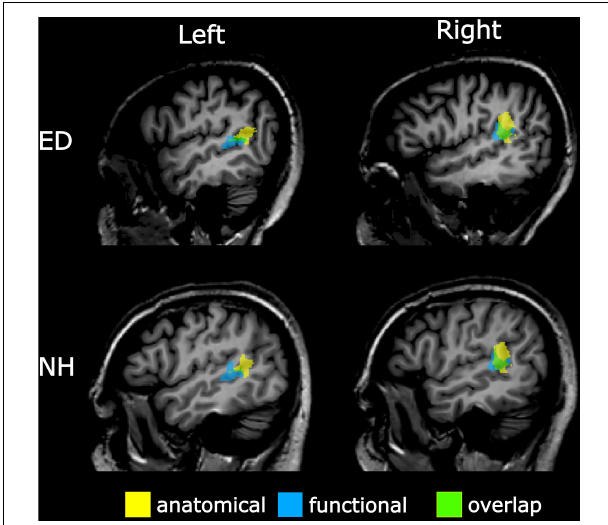
FIGURE 3 | Overlap between anatomically and functionally defined pSTS region. Sagittal view of left (left panel) and right (right panel) pSTS regions defined anatomically via the AICHA (yellow) and functionally via a visual–motion localizer (blue) on a representative ED (top panel) and NH participant (bottom panel). Overlapping voxels between anatomical and functional pSTS regions are displayed in green.